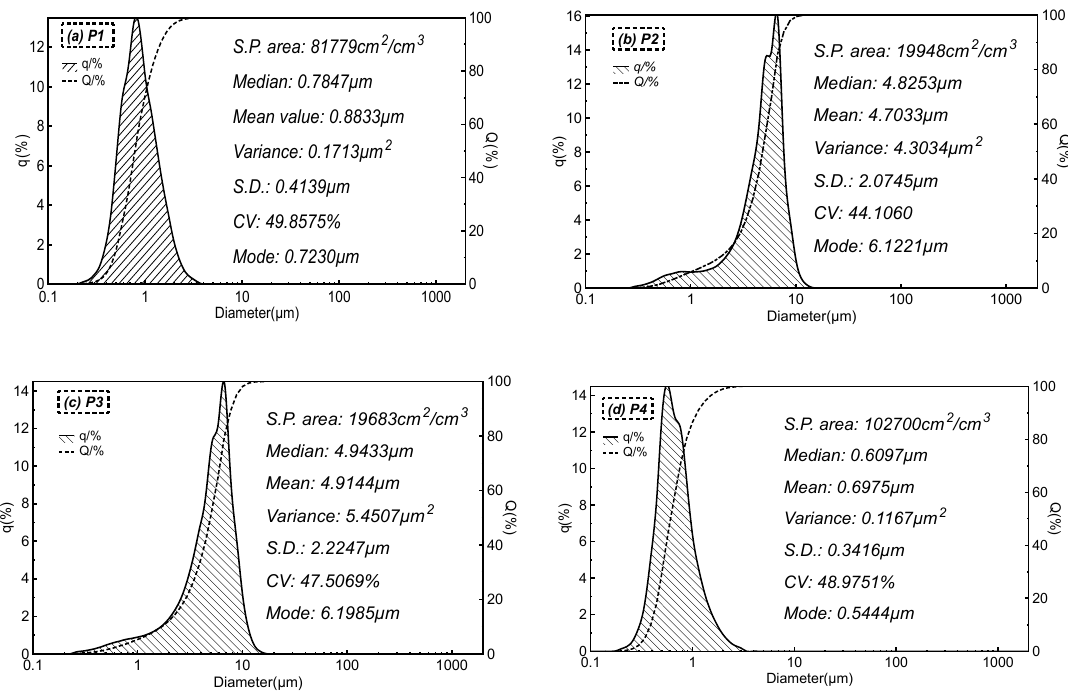
Figure 6. Size distribution of particles (q: density distribution of the particle size; Q: cumulative distribution of the particle size). ( a ) P1; ( b ) P2; ( c ) P3; and ( d ) P4)